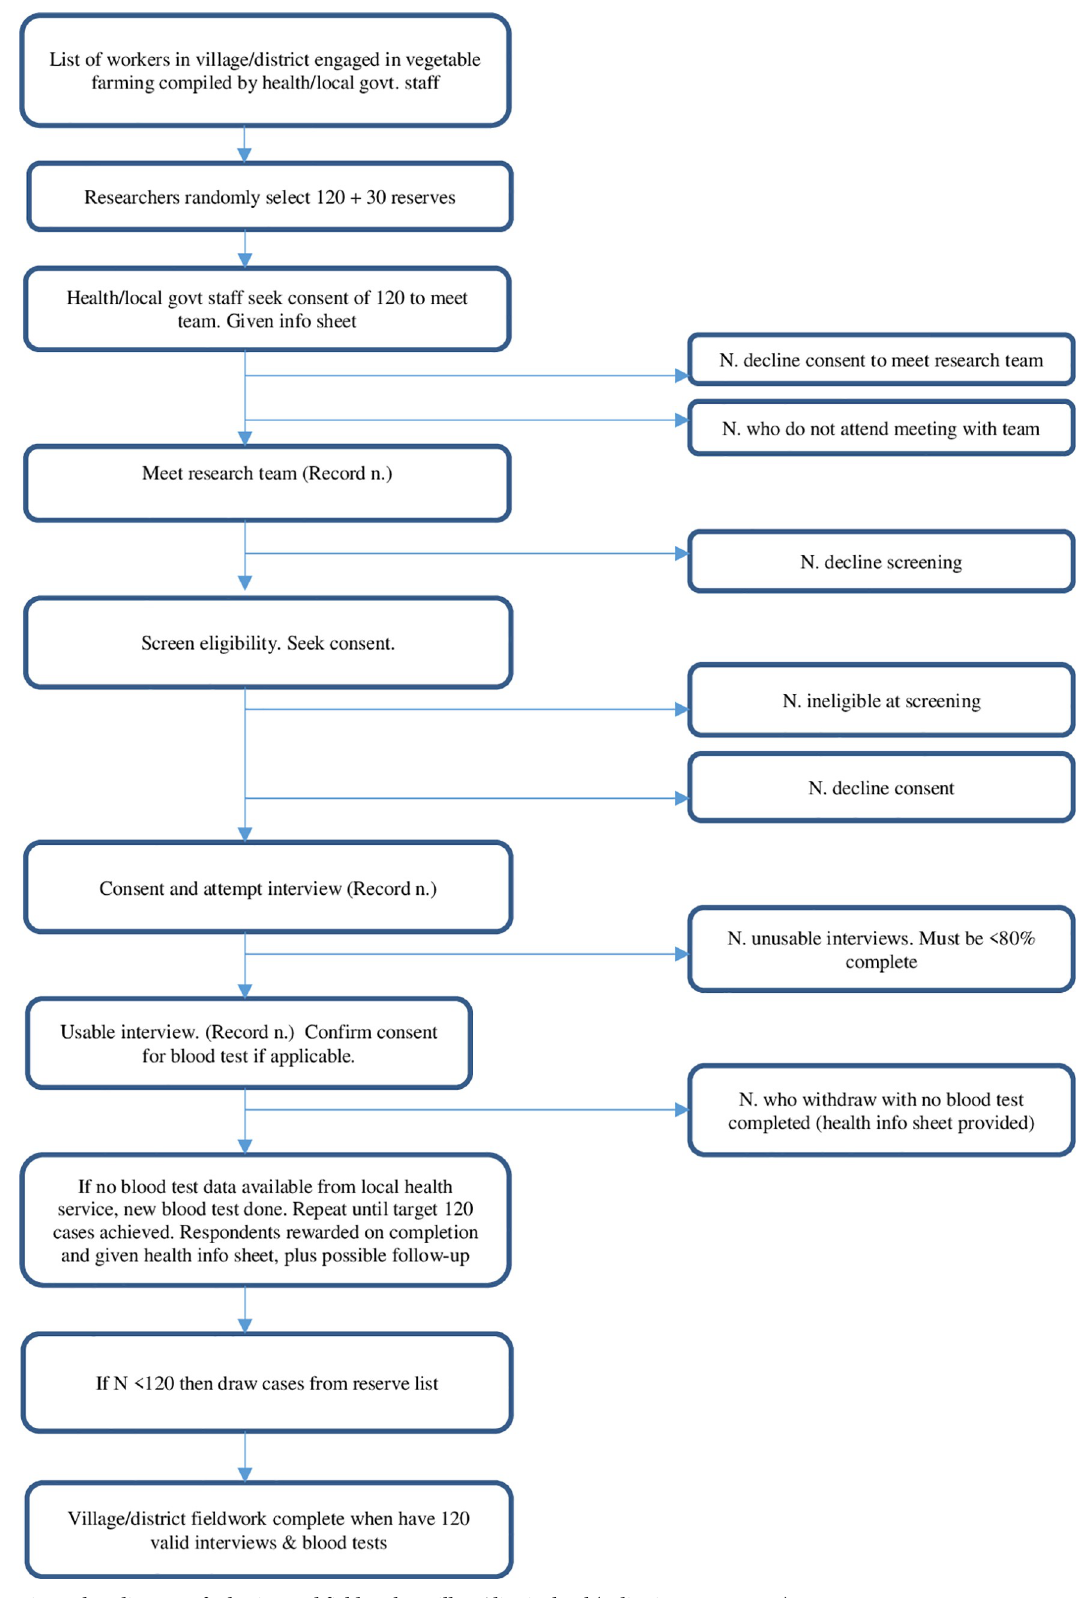
Fig 1. Flow diagram of selection and fieldwork at village/district level (3 districts per country). https://doi.org/10.1371/journal.pone.0258134.g001 PLOS ONE | https://doi.org/10.1371/journal.pone.0258134 September 30,